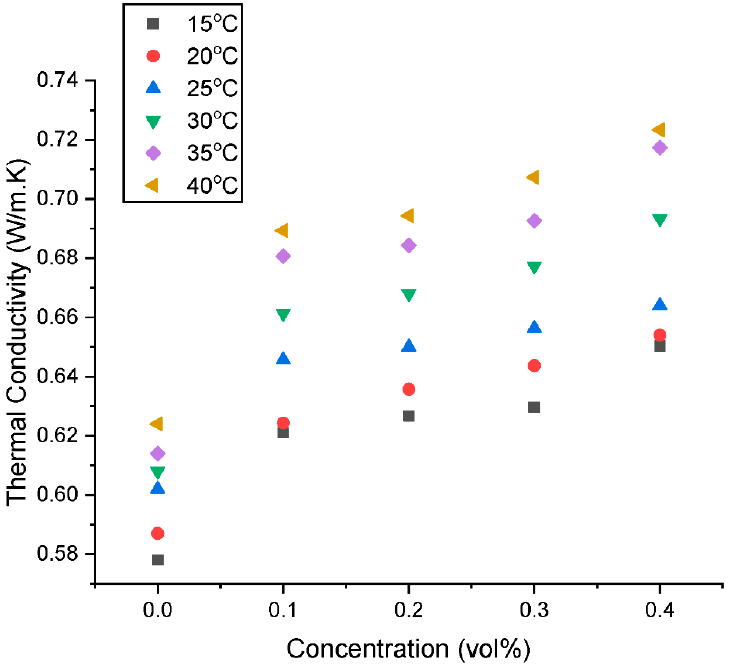
Figure 9. Influence of concentration on the thermal conductivity of the hybrid nanofluids at various temperatures.